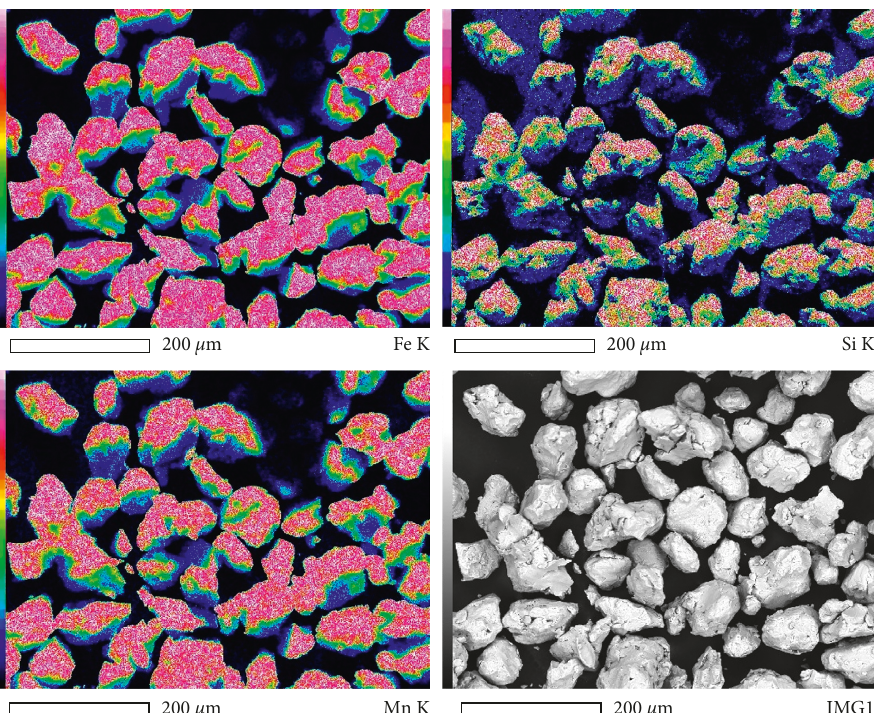
Figure 1: SEM and EDX analysis of Fe-30Mn-6Si MA powders.